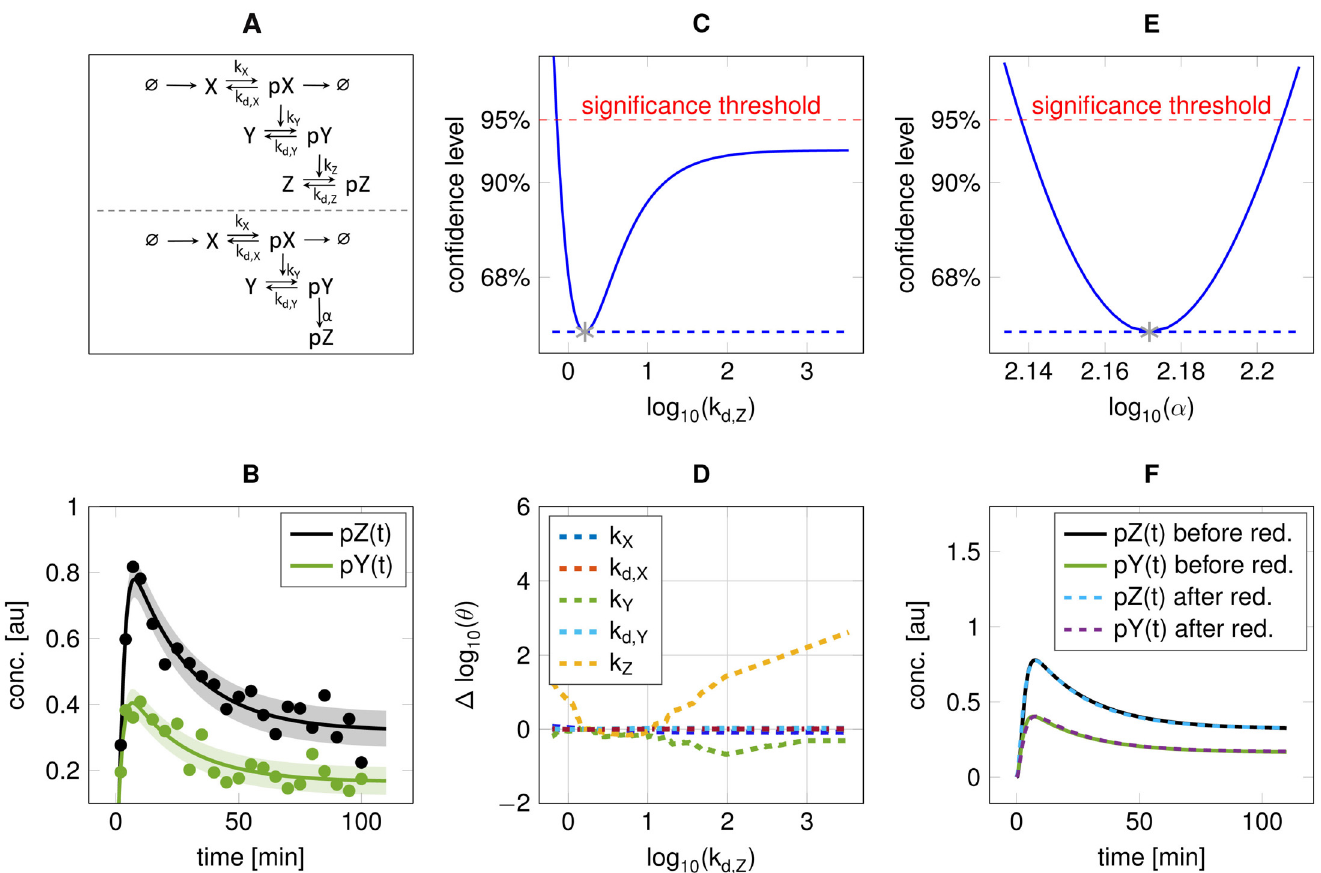
Fig 4. Reduction through functional relation (scenario 3). A: Model scheme before (upper) and after (lower) reduction. The difference is the removal of state Z , and the algebraic replacement pZ ( t ) = α (cid:5) pY ( t ). B: pY ( t ) and pZ ( t ) with simulated data after fitting. C: Profile likelihood for parameter k d , Z . D: Re-optimisation of remaining parameters along the profile likelihood for k d , Z . E: The profile likelihood for the identifiable parameter α in the reduced model. F: Comparison of trajectories for pY ( t ) and pZ ( t